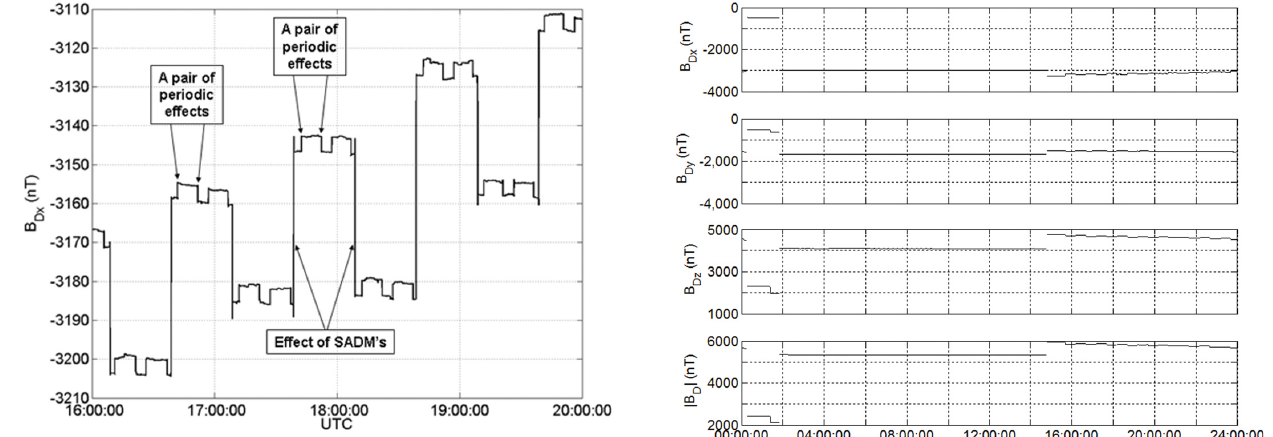
Fig. 2. B D (t) for the orbit (24h) on 14 July 2006 in the spacecraft coordinate